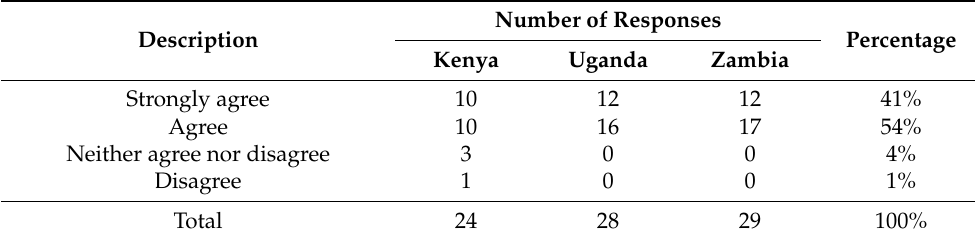
Table 4. Perceptions that the target community is better off after STDM